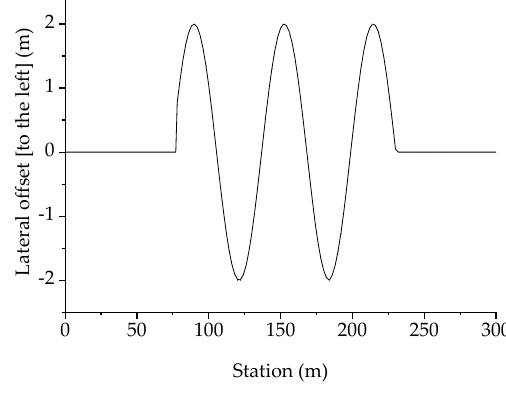
Figure 6. Driving